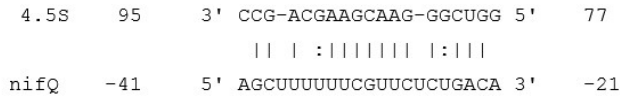
genome, with 164 nucleotides divided into DR (54 nucleotides) palindromic repetitions and spacing